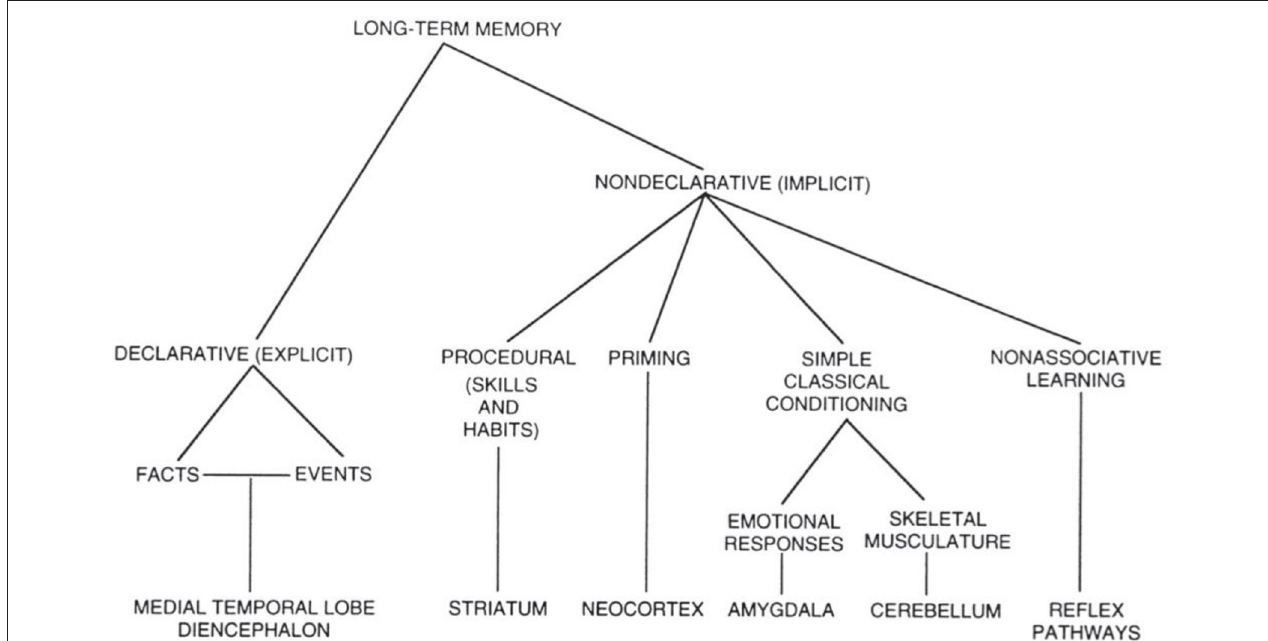
FIGURE 1 | Taxonomy of the division of mammalian long term memory systems. From Squire (2004).